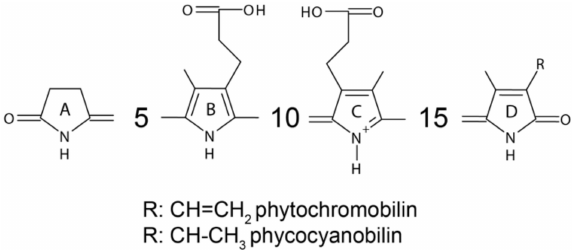
Figure 9. Chemical structure of Phytochromobilin and